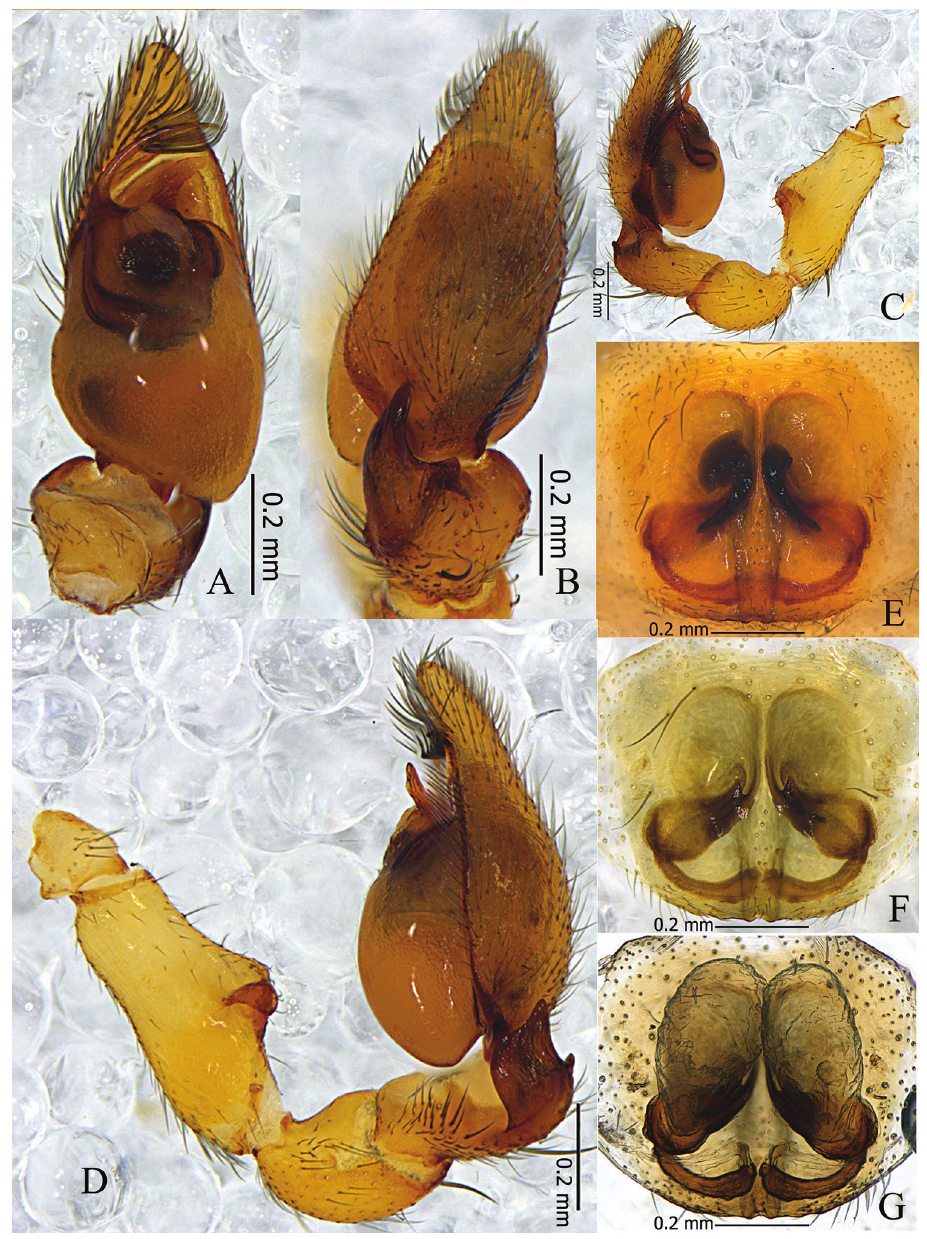
Figure 5. Otacilia yangmingensis sp. n. A left male palp, ventral view B same, dorsal view C same, pro- lateral view D same, retrolateral view E epigyne, ventral view F same, cleared by potassium hydroxide, ventral view G vulva, dorsal